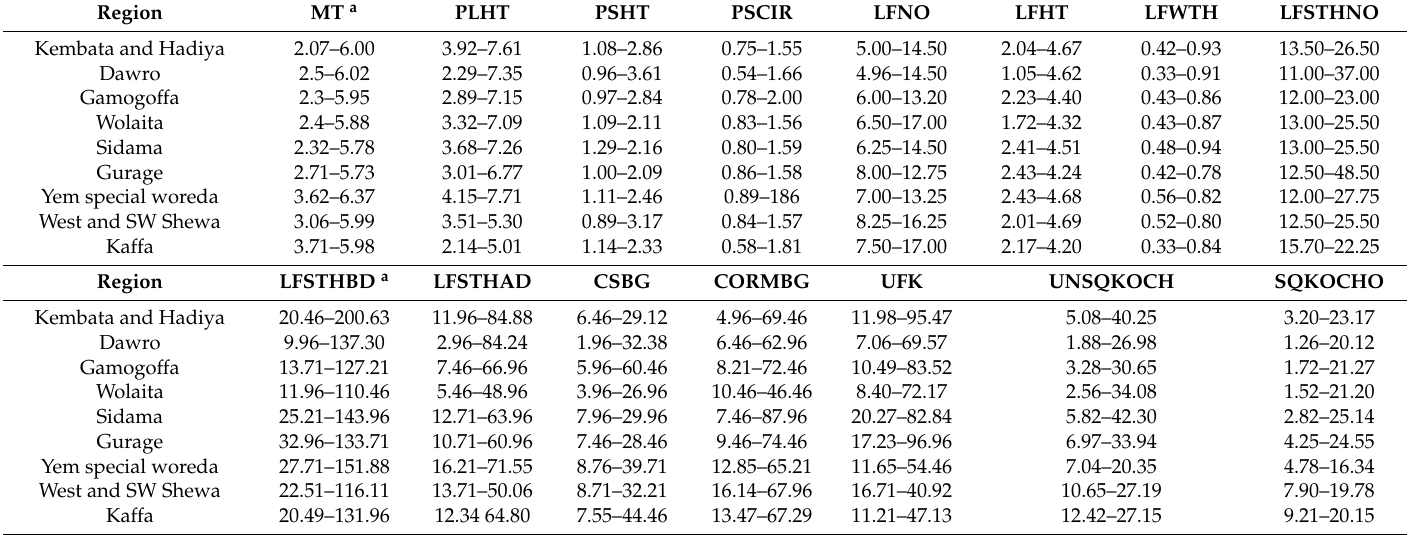
Table 4. Ranges of accessions means for 15 quantitative characteristics in enset germplasm by region of origin.